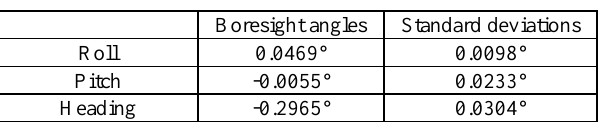
Figure 12: Results from Test #2